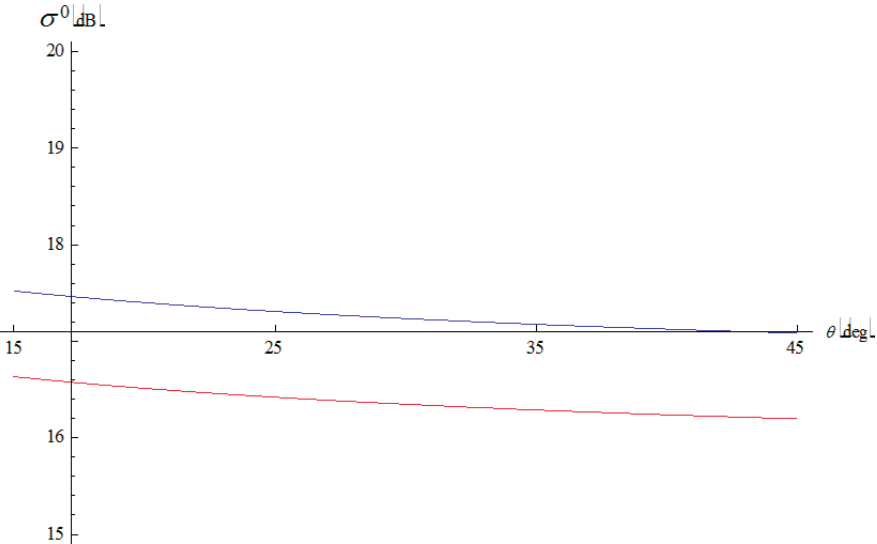
Figure 7. Ratio between the backscattering coefficient of a rough terrain and of surface water as a function of the incidence angle evaluated with the SPM at X- (blue line) and C- (red line)